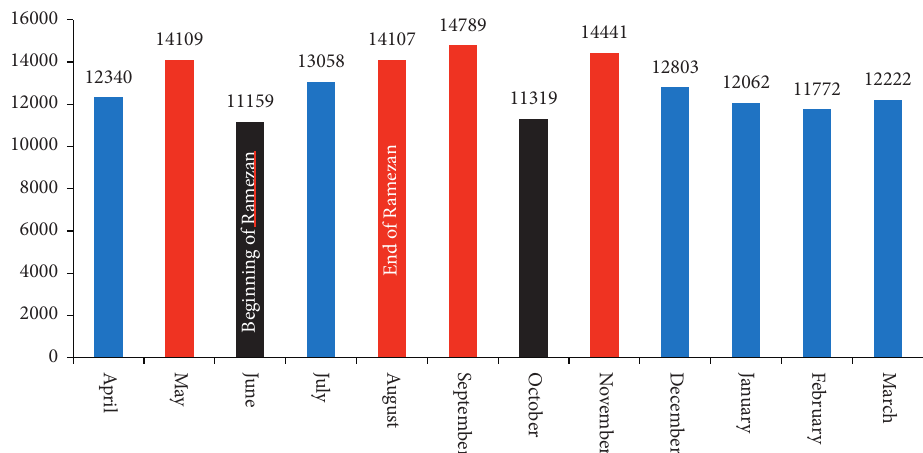
Figure 5: The bar graph of the number of public passengers (thousand) in different months of 2019.